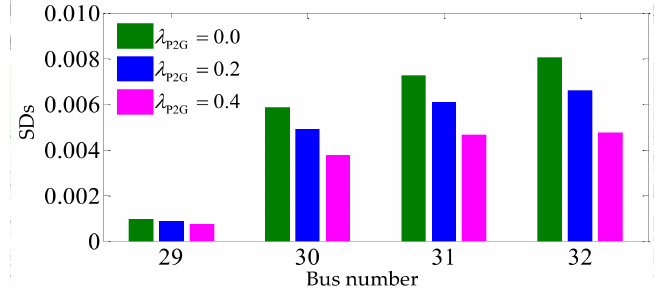
Figure 6. CDFs of voltage magnitude of bus 32.